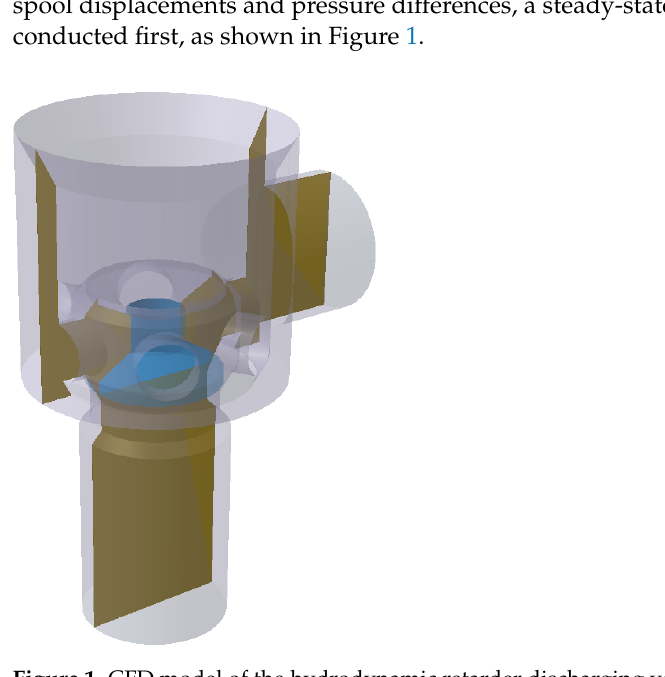
Figure 1. CFD model of the hydrodynamic retarder discharging